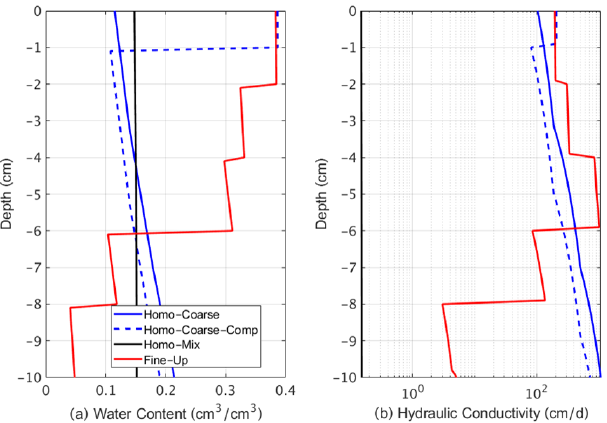
Figure 7. Simulation results of water content (a) and hydraulic con- ductivity (b) along the four modeled setups 48h after evaporation onset. (Fig. 9) for the saline solution and DI water,